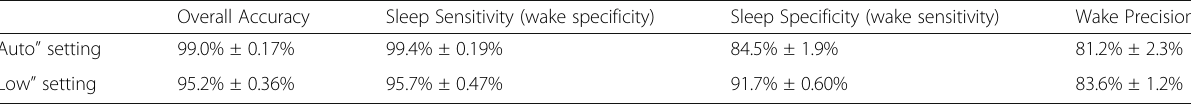
Table 2 Overall accuracy and comparative performance of Arc in detecting sleep/wake during the main sleep periods, in comparison to gold-standard determination of “ sleep ” and “ wake ” Actiwatch using the preset auto and low settings of the Actiwatch software